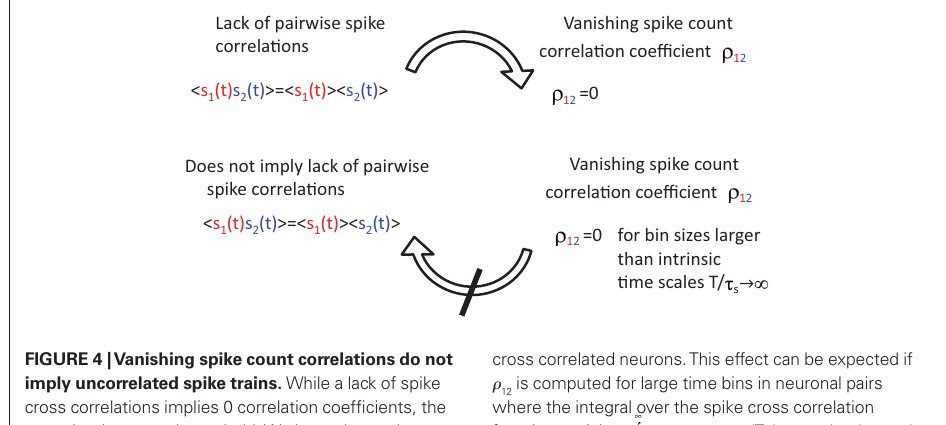
cross correlated neurons. This effect can be expected if Figure 4 | Vanishing spike count correlations do not r is computed for large time bins in neuronal pairs imply uncorrelated spike trains. While a lack of spike 12 where the integral over the spike cross correlation cross correlations implies 0 correlation coefficients, the −∞∞ function vanishes ∫ = opposite does not always hold. We have shown that count correlation coefficient r can vanish in pairs of 12